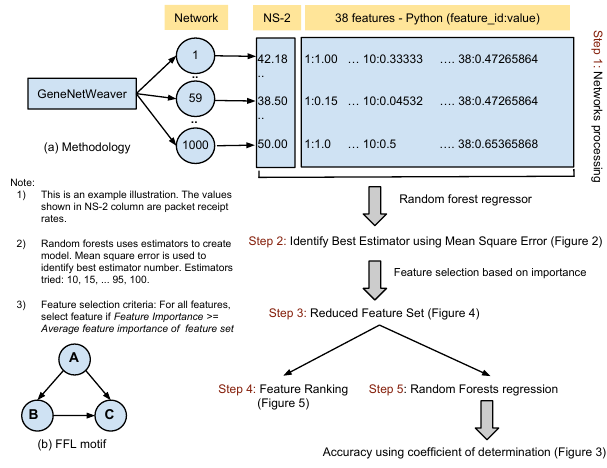
Figure 1: (a) Step-by-step methodology (b)